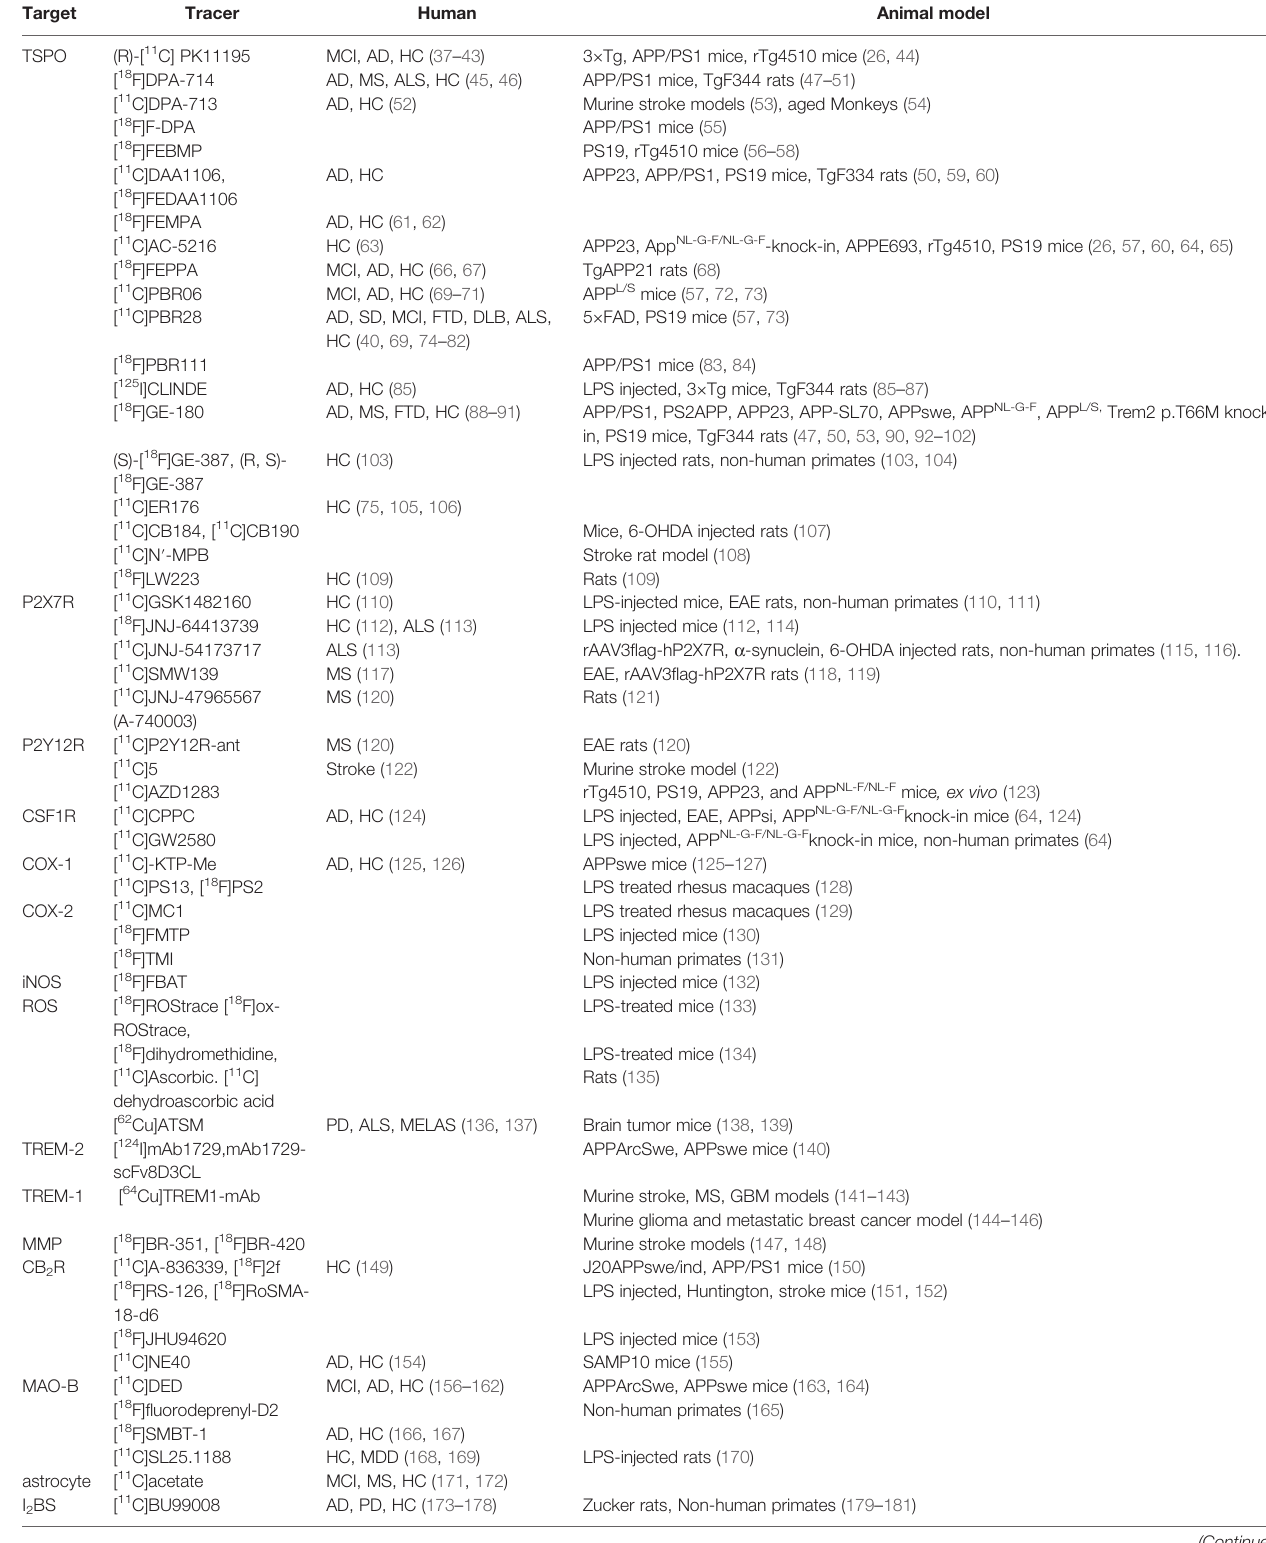
TABLE 1 | Summary of imaging probes for